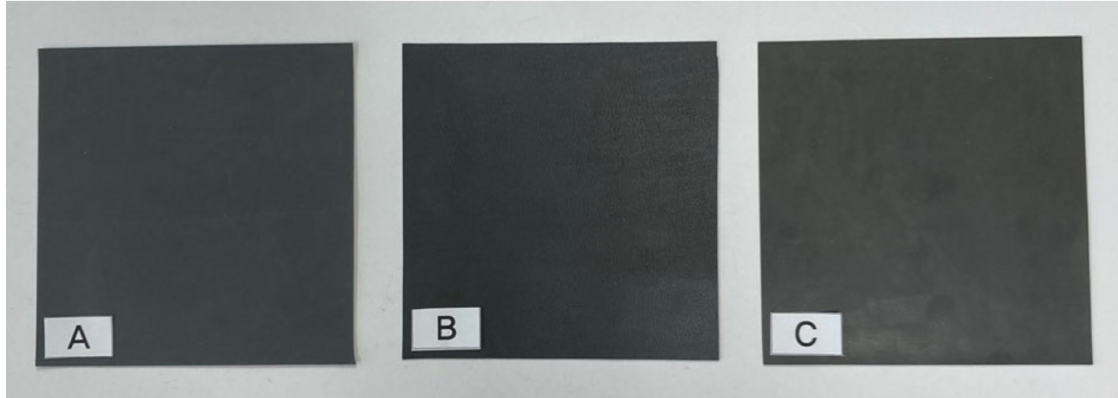
Figure 2. Appearance of final shielding sheet. ( A ) microparticle sheet; ( B ) nanoparticle sheet; ( C ) mixed nanoparticles and microparticles